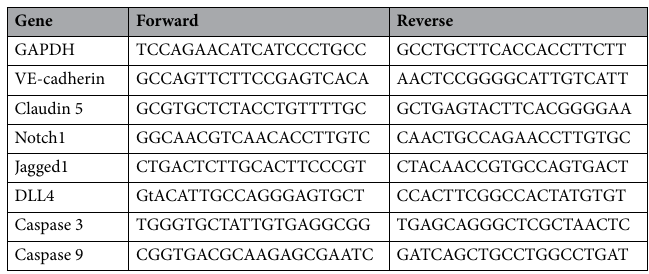
Table 2. Designed primers for